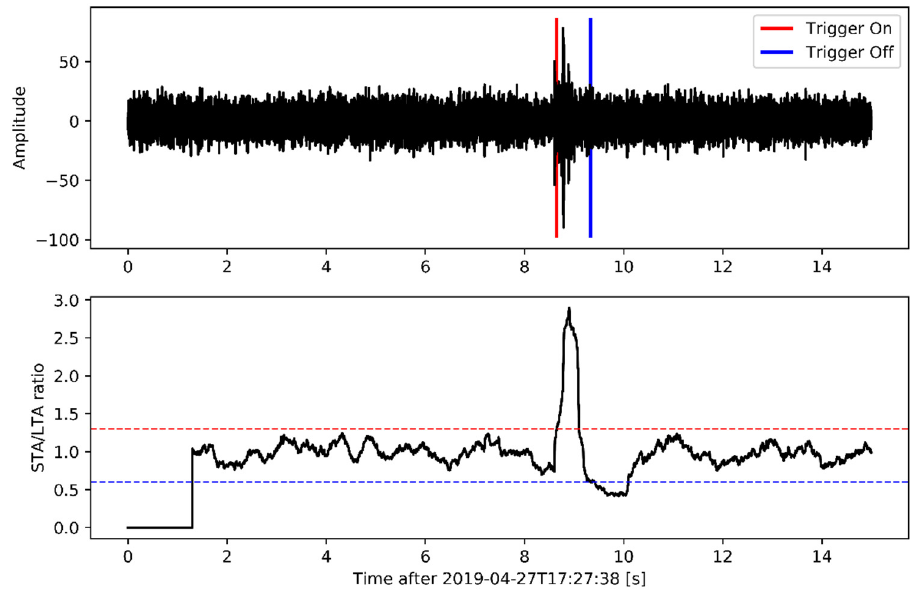
Figure 15. An example of the STA/LTA implementation for the detection of microseismic events. ( Top ) Amplitude spectrum of the waveform. ( Bottom ) STA:LTA ratio plot. An event is declared when the STA:LTA ratio exceeds 1.3. Red and Blue dotted lines indicate the thresholds above and below which the trigger is on and off respectively.